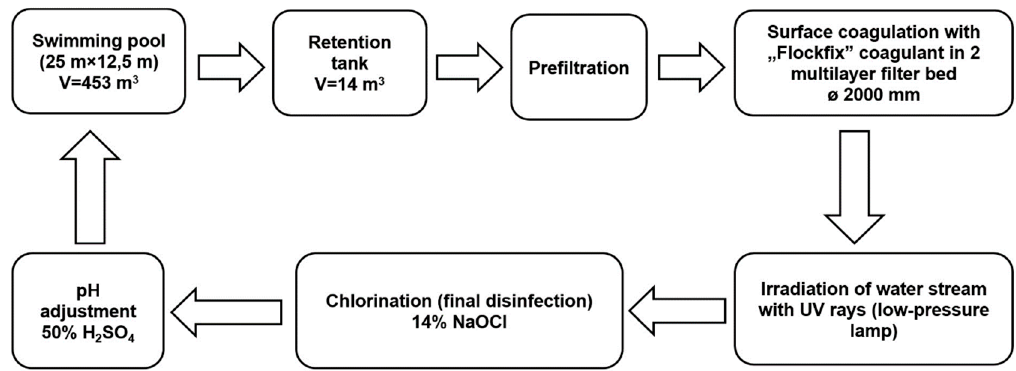
Figure 1. The scheme of water treatment in tested swimming pool.